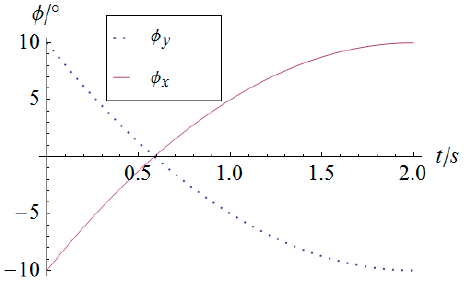
Sensors 2016 , 16 , 1485 Figure 5. Angular displacement vs. time of the actuators. Figure 5. Angular displacement vs. time of the actuators. Figure 5. Angular displacement vs. time of the actuators.